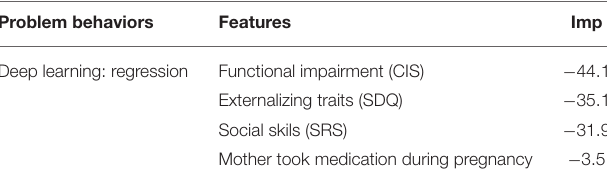
TABLE 6 | Optimized predictors of problem